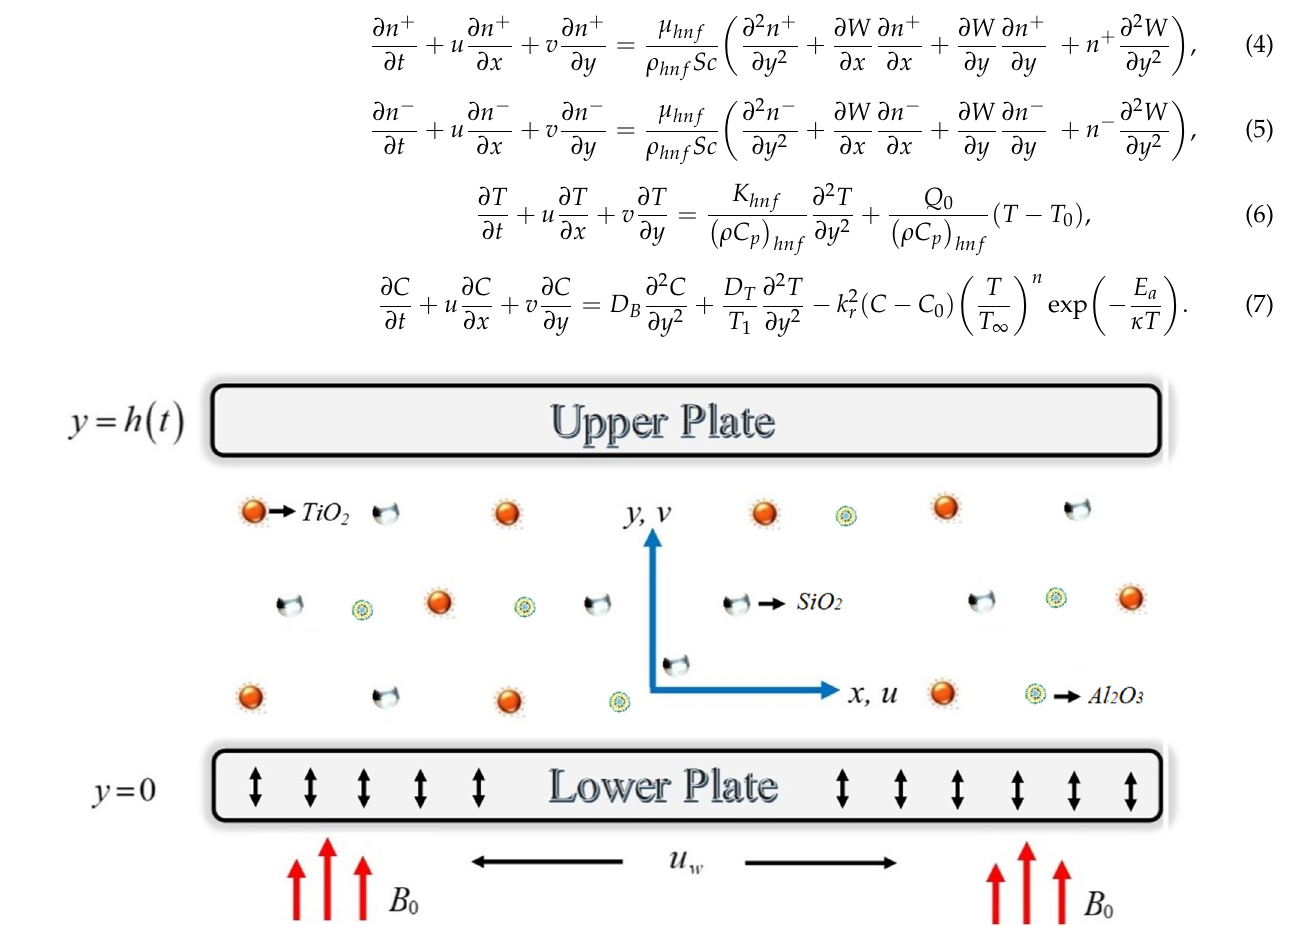
Figure 1. Electroviscous fluid flow across two parallel plates.